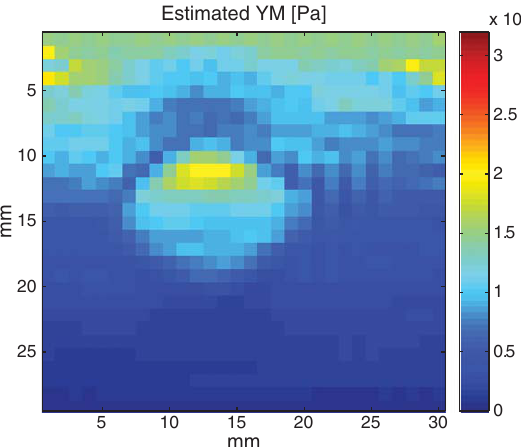
Fig. 5. The stiffness distribution is calculated with an elastography basedapproach.Hereisreportedanexampleofstiffnessdistribution estimated with a direct elastography method. From [30].